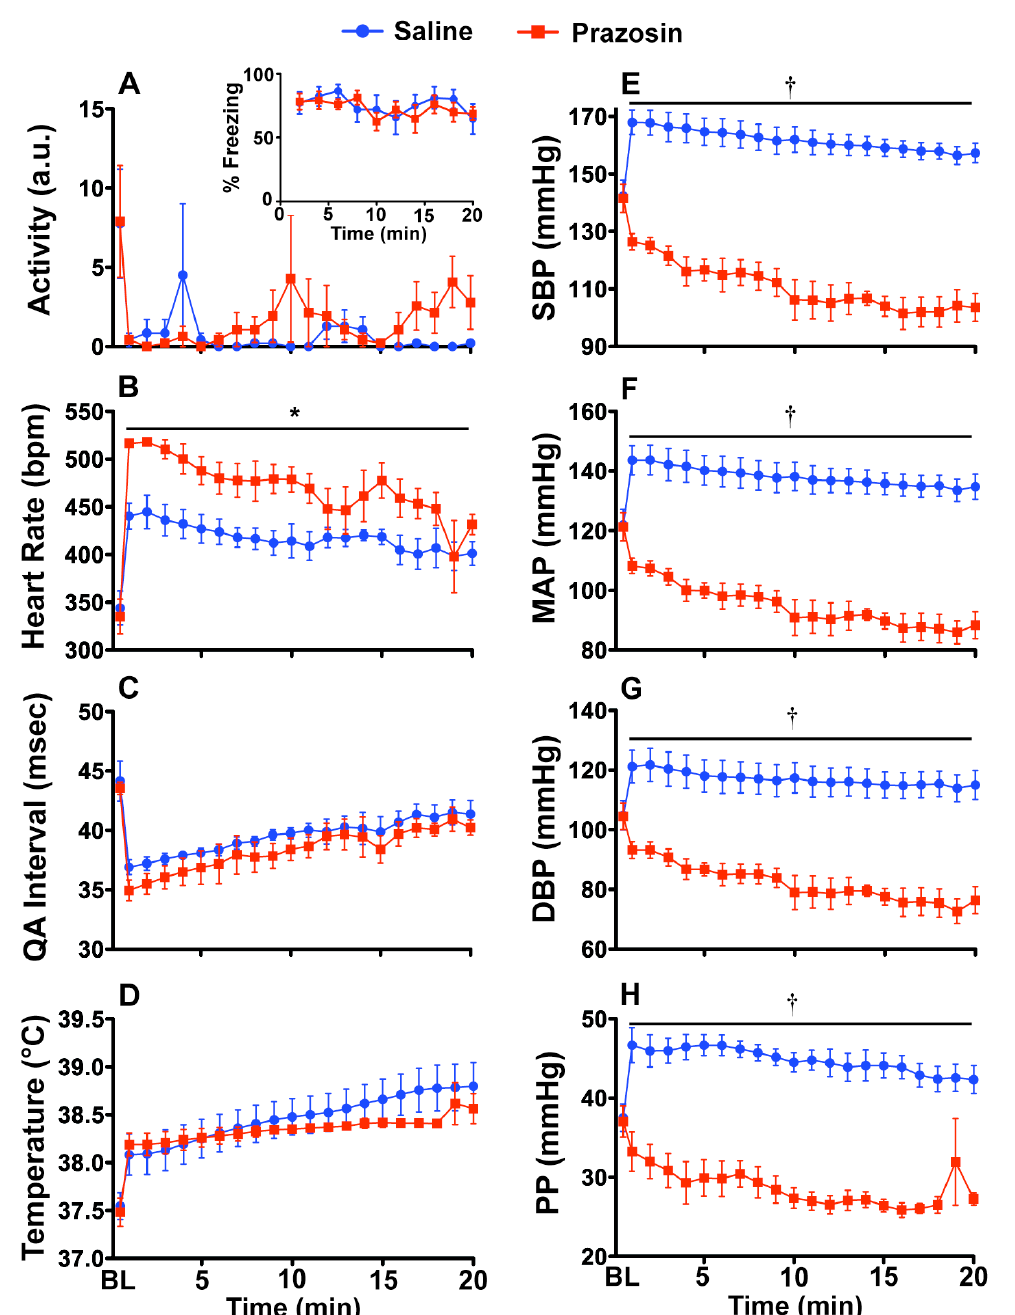
Figure 2. Prazosin (1.0 mg/kg) blocks fear-evoked increases in blood pressure during CFT. In vivo telemetry responses during acute CFT. Rats were either injected ip with saline or prazosin 10 min before exposure to the conditioned context. ( A ) Prazosin had no effect on freezing behavior (inset) or locomotor activity; ( B ) Heart rate was increased in prazosin injected rats, likely to compensate for decreased blood pressure; There was no effect of prazosin on the ( C ) QA interval or ( D ) body temperature; ( E – H ) Prazosin prevented the blood pressure increase during exposure to the CFT. Abbreviations are as follows: baseline (BL), arbitrary units (a.u.), systolic blood pressure (SBP), mean arterial pressure (MAP), diastolic blood pressure (DBP), pulse pressure (PP). (*p < 0.05,